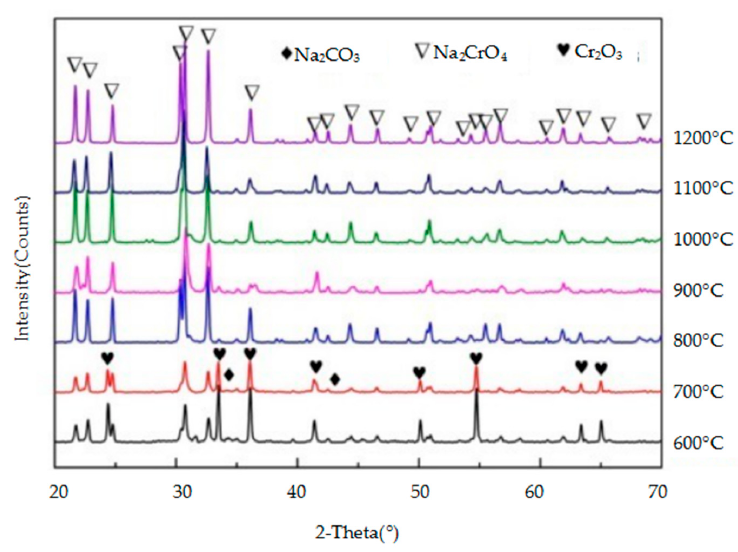
Figure 10. XRD patterns of the products of the reaction between Fe 2 O 3 and Na 2 CO 3 .